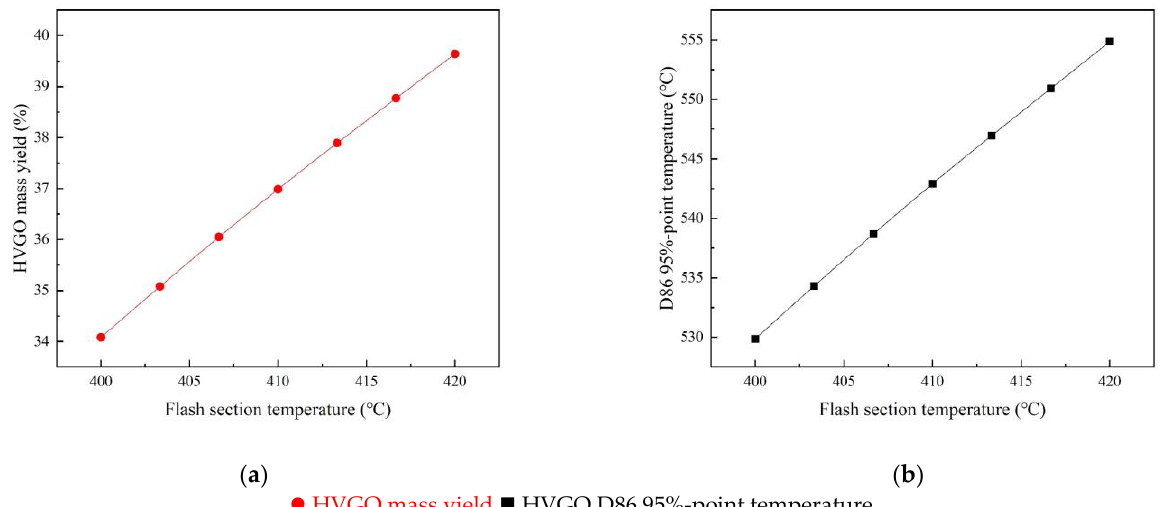
Figure 10. Effect of FST on deep-cut vacuum distillation. ( a ) HVGO yield change; ( b ) HVGO D86 95%-point temperature change.